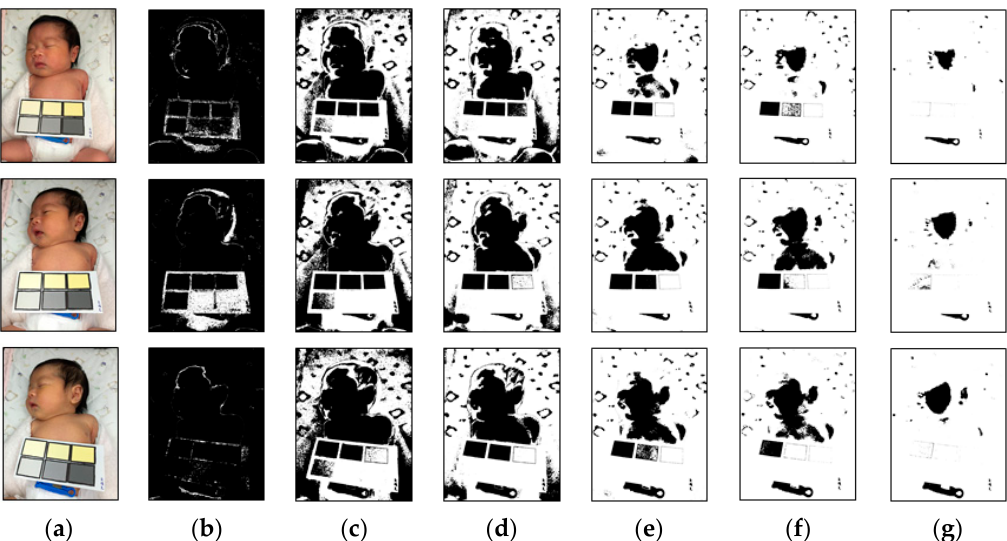
Figure 3. Results of the first processing step for the original images. ( a ) Original images with various color temperatures (32, 48, and 65 K from top to bottom). ( b – g ) The produced results with W r values of 0.1, 0.5, 0.7, 1.0, 1.2, and 1.5. The white regions in the images are the white candidates.